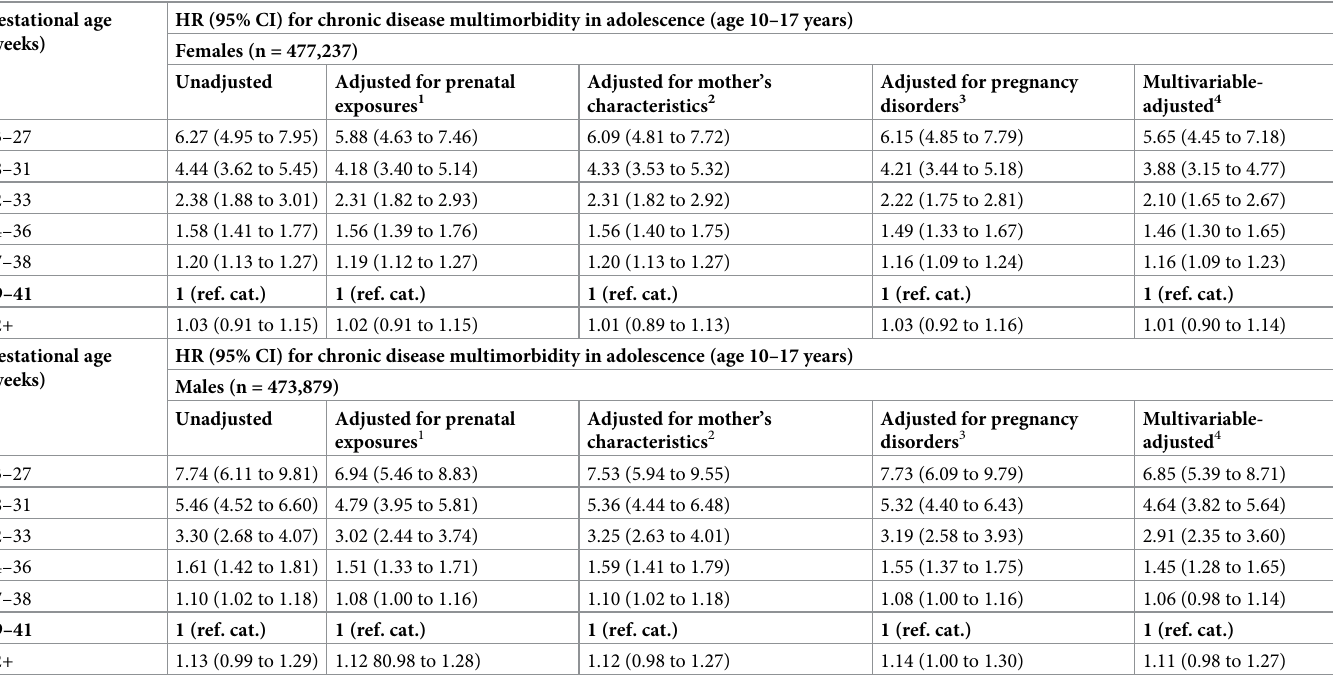
1 Birthweight z-score (continuous), multiple pregnancy (yes vs. no) and congenital anomalies (yes vs. no) 2 Mother’s age (years, continuous), parity (0, 1, 2, 3, 4, 5+), smoking during pregnancy (yes vs. no) and socioeconomic position (low, intermediate, high, not known) 3 Adjusted for mother’s diabetes (none, gestational diabetes, type 1/type 2 diabetes) and mother’s hypertension during pregnancy (yes vs. no) 4 Adjusted for all the above